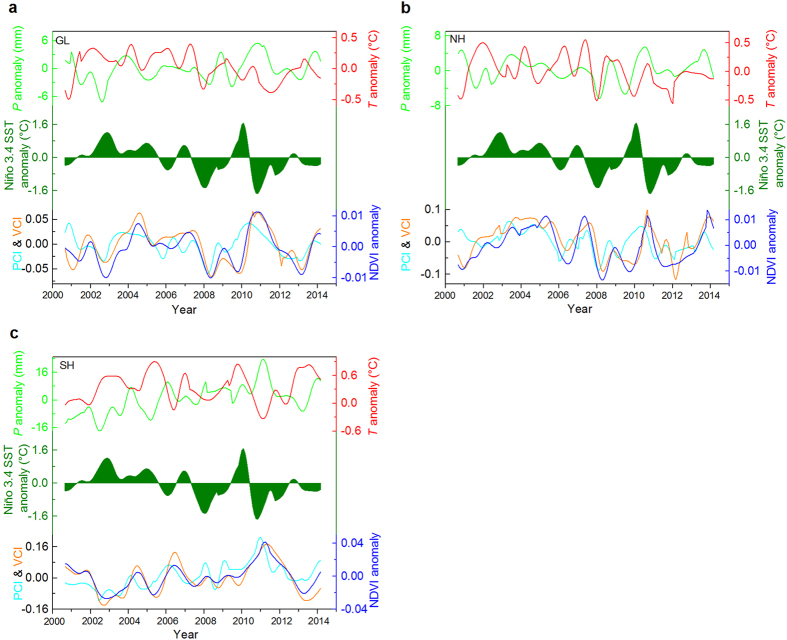
Variability extracted using the Ensemble Empirical Mode Decomposition (EEMD) method across semi-arid areas from 2000 to 2014.(a), Temporal evolution of variability for monthly mean Niño3.4 index (olive shading), Climate Research Unit (CRU TS3.23) precipitation anomaly (P anomaly, green line), temperature anomaly (T anomaly, red line), TRMM precipitation condition index (PCI, cyan line), MODIS vegetation condition index (VCI, orange line) and NDVI anomaly (blue line) over Global (GL) semi-arid areas. (b,c), As in a, but for the Northern Hemisphere (NH) and Southern Hemisphere (SH) semi-arid areas. The PCI, VCI and NDVI anomaly are unitless.